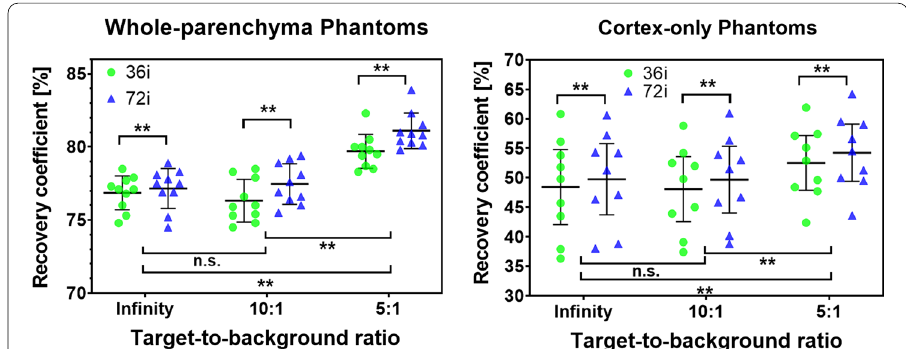
Fig. 4 Measured recovery coefficients of each phantom. Measured recovery coefficients (RCs) of each phantom in the study for any combination of the target-to-background ratio and iteration number (green points, 36 iterations; blue triangles, 72 iterations). Values for the whole-parenchyma and cortex-only kidney phantoms are shown in left and right subfigures, respectively. The solid horizontal line for each group represents the mean; the associated whiskers indicate plus/minus one standard deviation. Additionally, the result of the nonparametric testing is provided. Two asterisks (**) indicate a statistically significant difference with a p < 0.01, not significant (n.s.) indicates that a statistically significant difference was not found. Test results between the RCs of reconstructions with different iteration numbers are displayed above data points. Test results between RCs at different TBRs are shown below the data points. Values were obtained for LEHR collimation and the radionuclide 99m